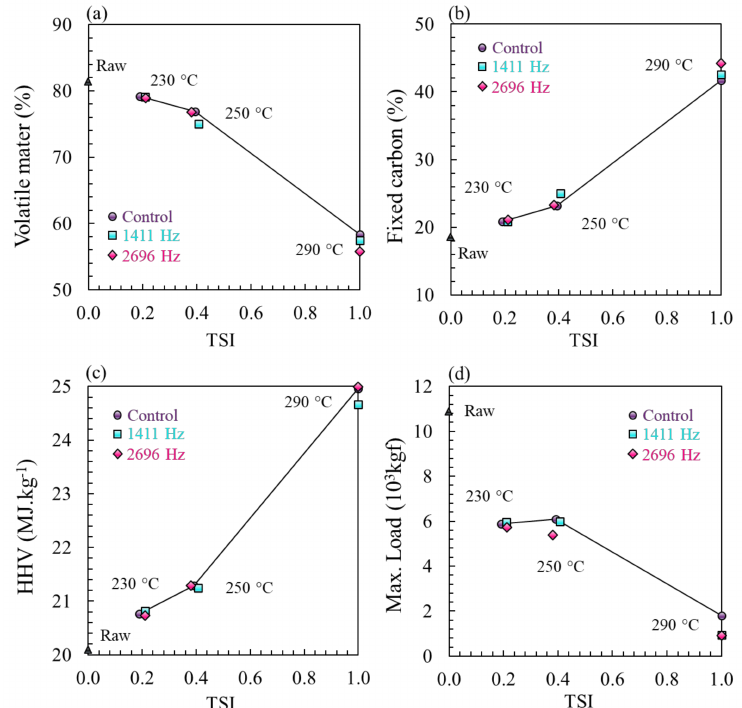
Figure 4. Results for ( a ) volatile mater, ( b ) fixed carbon, ( c ) higher heating values (HHV), and ( d ) compression strength in function of TSI for control, 1411, and 2696 Hz under 230, 250, and 290 ◦ C temperature